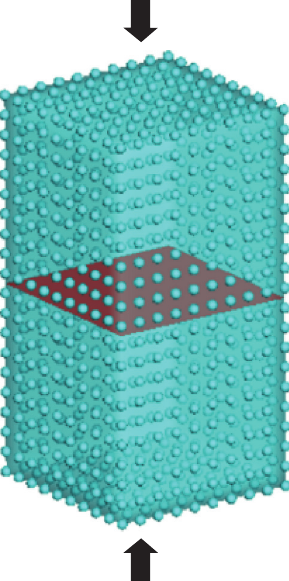
Figure 4: Model and field node distribution diagram.